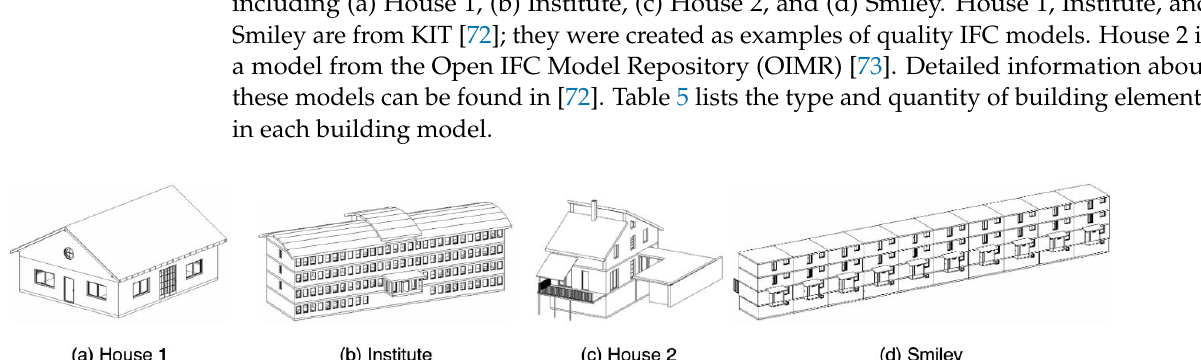
Figure 12. BIM models used in this study for validation. Table 5. Quantity of building elements in each model.